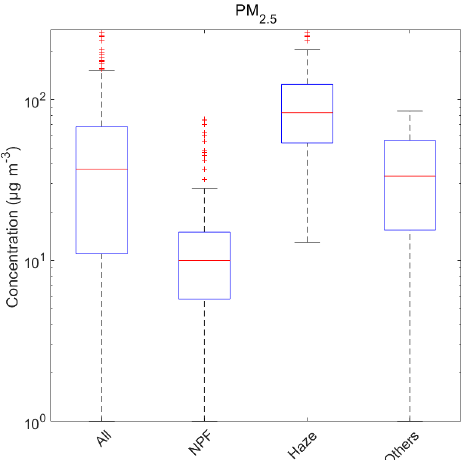
Figure 4. General character of the PM 2 . 5 mass concentration on all the days, NPF event days, haze days and others days. The boxes show the median (red line), 25th and 75th percentiles of the PM 2 . 5 mass concentration. Data marked with red plus symbols represent outliers as in Fig. 1.